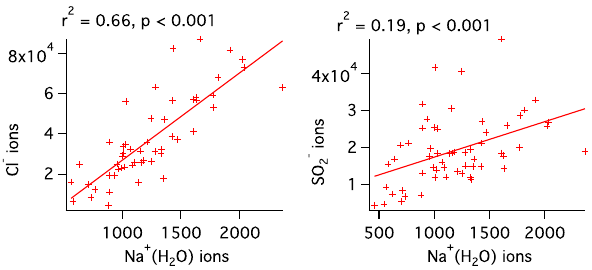
Figure 6. Correlations between the largest sodium peak and the two main negative ions, Cl − and SO − . Three points prior to midnight 2 on 26 May were excluded, due to very high sulfate levels attributed to a volcanic plume. Both linear slopes are greater than two standard deviations above zero. Most Cl − variability can be attributed to the presence of sea salt, for which sodium is a proxy. The variability in particle sulfate, measured as SO − , is only explained to a small 2 extent by the presence of sea